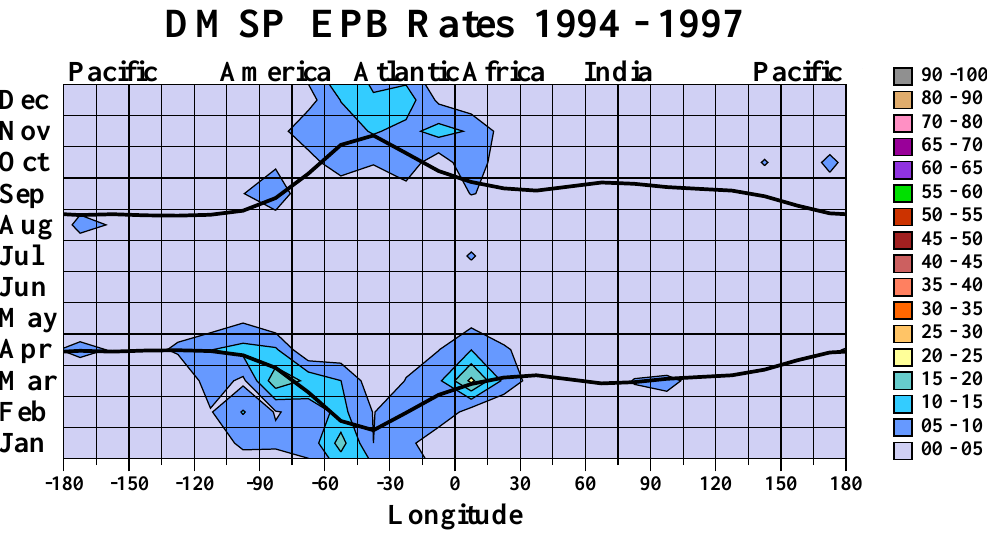
Fig. 6. Contour plot of EPB rates for solar minimum 1994–1997 in the same format as Fig. 3. EPB rates were generally < =5%. Highest rate (21%) occurred in the Africa sector in